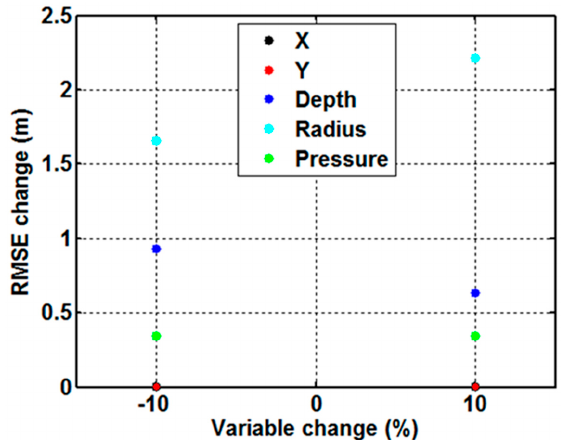
Figure 9. The contribution of variations in input parameters to the output of the surface deformation model, determined by changing the variables within 10% from the estimated values. Note that the values for X and Y are plotted in the same location.